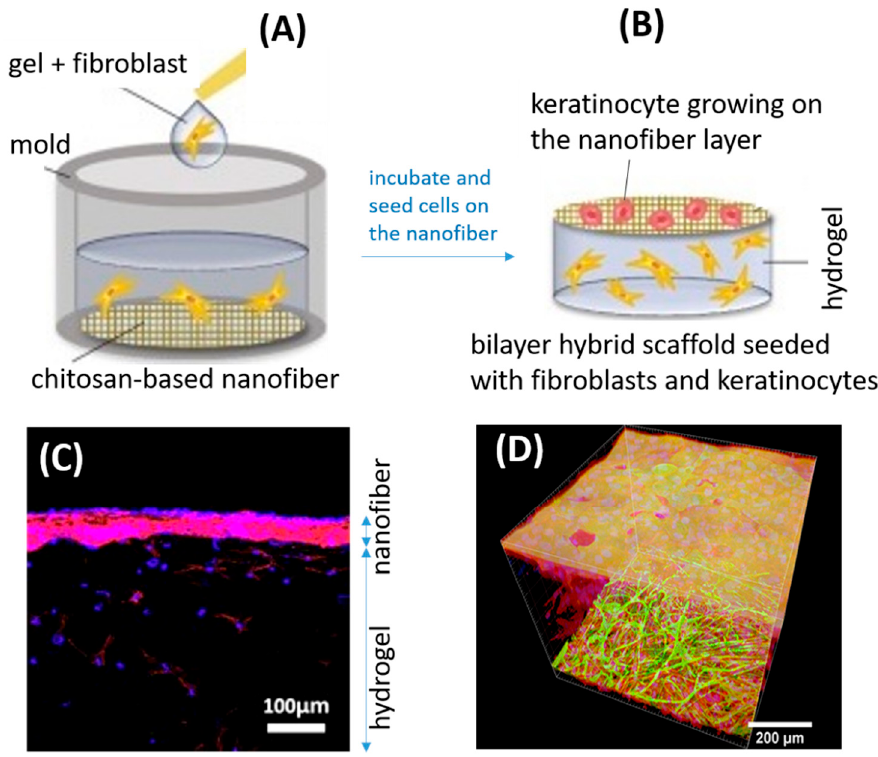
Figure 7. A bilayer scaffold composed of a nanofiber mat and a hydrogel mimics the layered nature of skin. The chitosan-based nanofiber was prepared by electrospinning, while the hydrogel was synthesized by photopolymerization. ( A ) Human fibroblasts were encapsulated in the gel and poured into a mold with the nanofiber mat placed on the bottom. ( B ) After a short incubation period, the hydrogel was flipped over with the nanofiber mat side up, and keratinocyte cells were seeded onto the nanofiber surface. After co-culturing, encapsulated fibroblasts (blue) proliferated in the hydrogel matrix, while keratinocyte cells (red) formed a layer on top of the fibrous scaffold, mimicking the epidermis and the dermis. ( C ) A cross-section of the cellularized bilayered material. Reprinted with permissions from [128] , copyright 2017 Elsevier. ( D ) A 3D scaffold made from a nanofiber-hydrogel composite and captured by confocal microscopy. The fibrin-coated nanofiber mat (green) enabled the fibroblasts (red) to migrate from the nanofibers and into the collagen hydrogel (middle layer), mimicking the skin’s dermis. Different from the 3D scaffold in ( B ), the hydrogel in ( D ) constitutes the top layer supporting the embedded keratinocytes (yellowish), mimicking the skin’s epidermis. Reprinted with permissions from [129] , copyright 2019 Dove Medical Press.